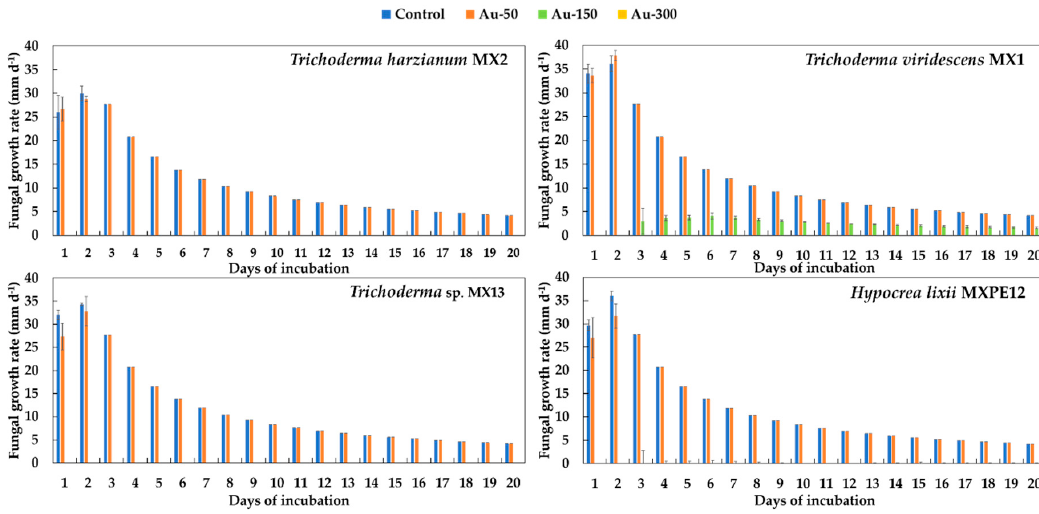
Figure 1. Fungal growth rate of filamentous fungi strains exposed to four doses of gold (mg L − 1 ) (n = 3, means ± standard error).